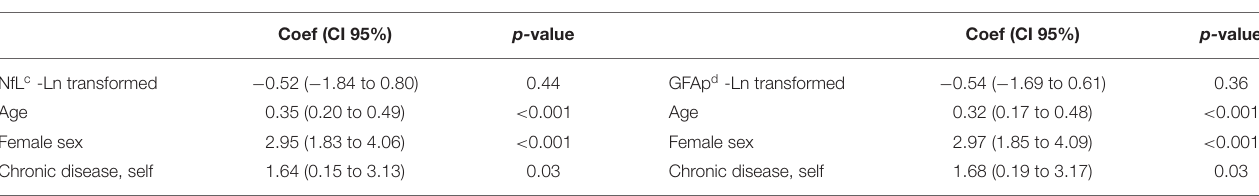
TABLE 5 | Association between chalder fatigue score and neuro-injury markers at